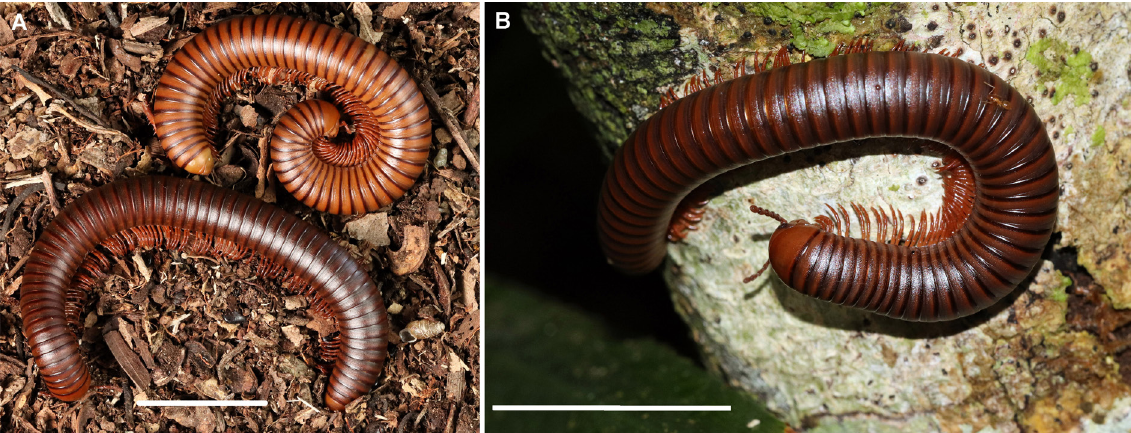
Fig. 3. Sechelleptus arborivagus sp. nov., in vivo habitus. A . Two females showing different color. B . Female on tree. Scale bars = 3